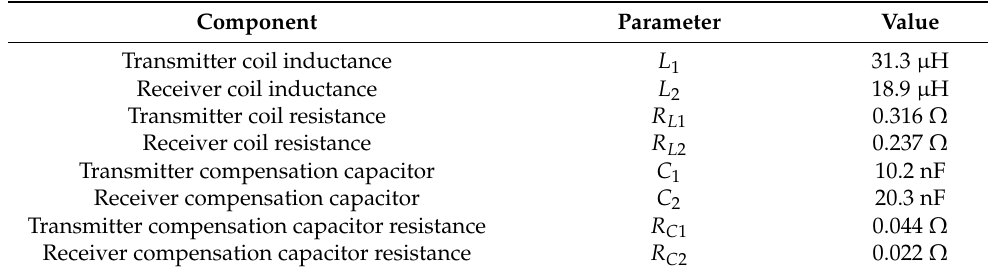
Table 1. Parameters of the magnetically coupled resonant wireless power transmission system. Component